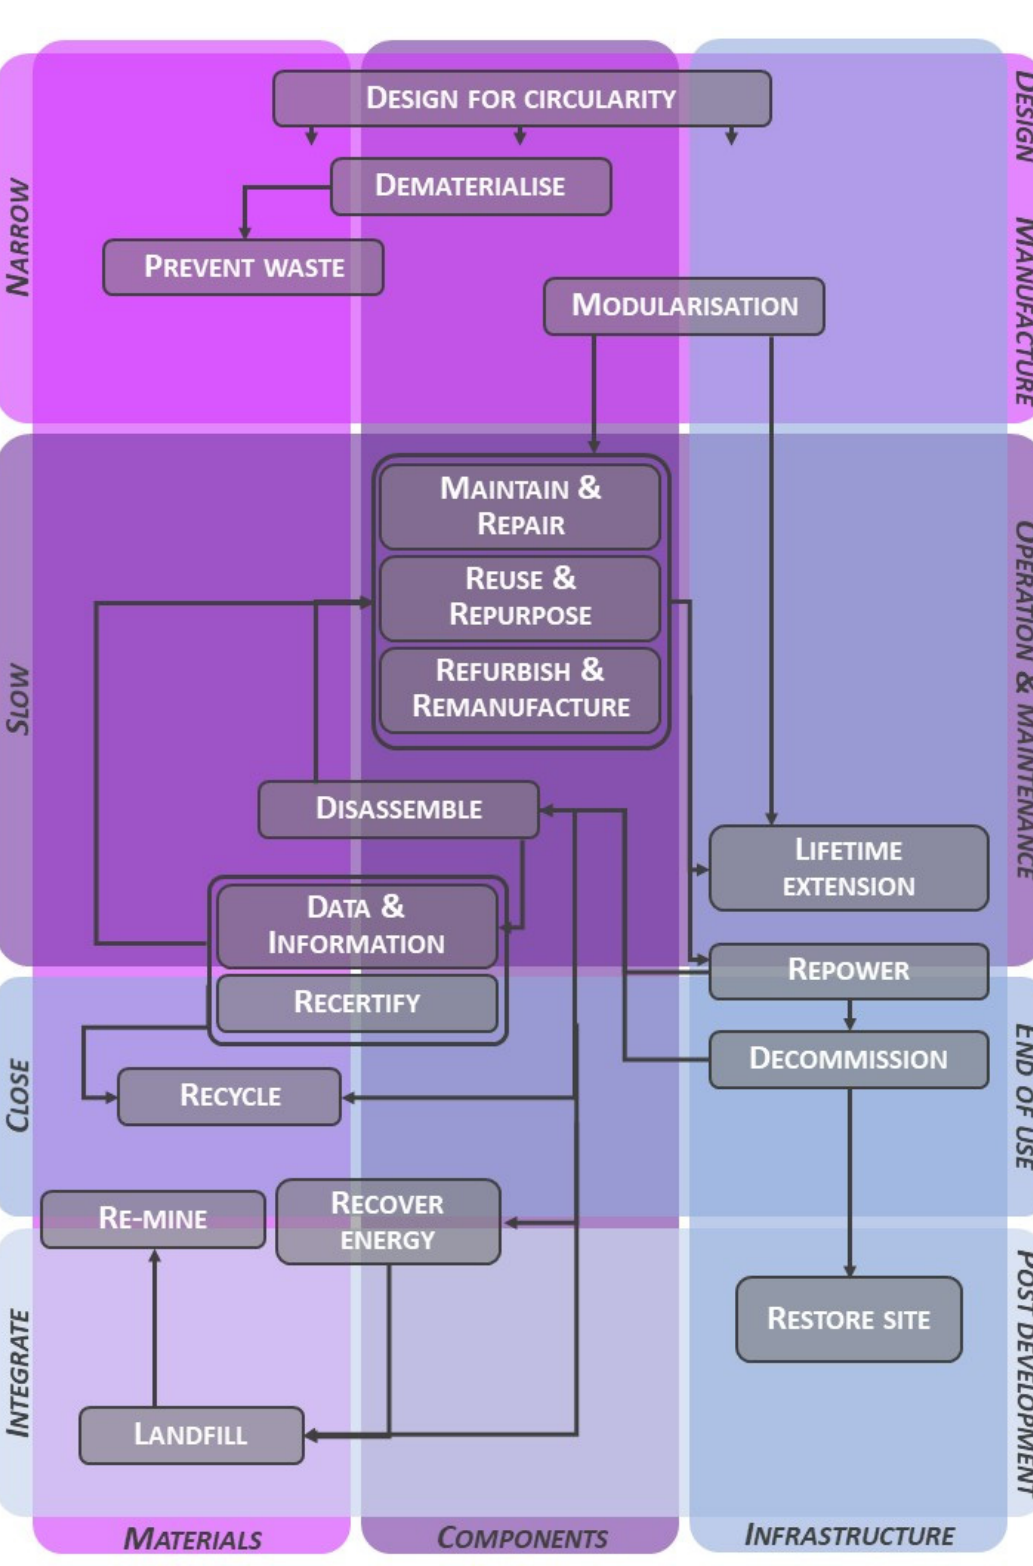
Figure 2. Circular economy strategies for offshore wind organised by their application to materials, components and whole infrastructure (columns), the narrowing, slowing and closing of resource flows and their integration into the environment (rows, left side), throughout the offshore wind infrastructure lifecycle, from design to the end-of-use and beyond (rows, right side). Arrows indicate that one strategy enables another—for example, disassembly enables remanufacturing, and maintenance and repair enable lifetime extension.